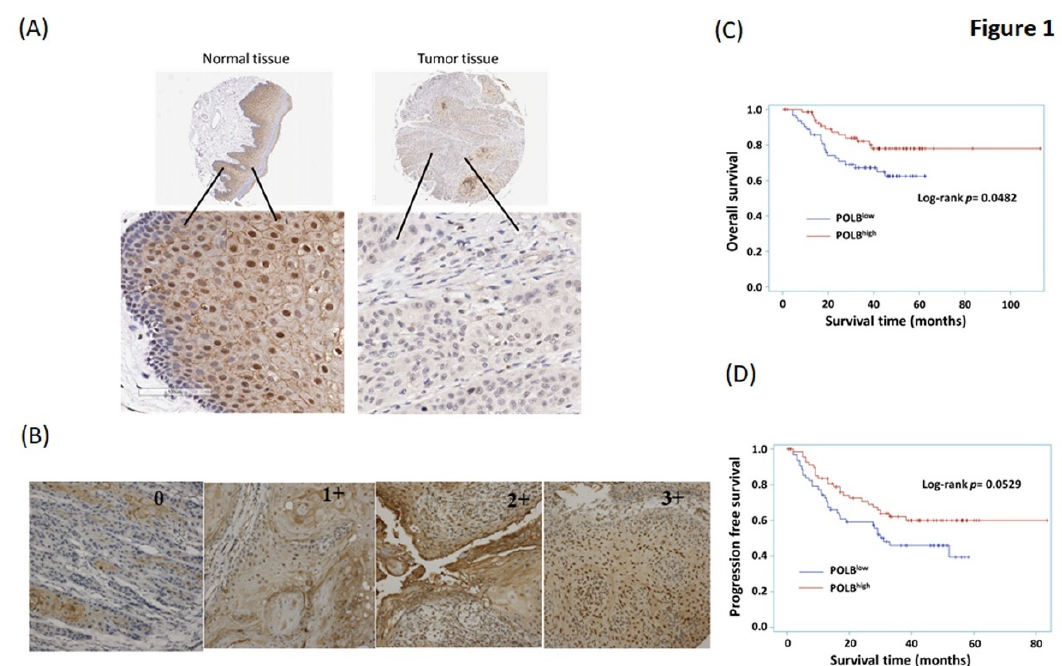
Figure 1. Representative immunohistochemistry staining results of POLB in tumor cells of OSCC patients, evaluation of POLB expression as a favorable prognostic marker in OSCC patients, and comparison of POLB protein expression between normal and OSCC cells in tissue array. ( A ) IHC representative images of POLB in OSCC cancer tissue sections are shown. ( B ) Immunoreactivity of POLB was classified as negative or positive (1+, 2+ and 3+) according to staining observed in the cell nucleus; magnification, 200 × . ( C ) The Kaplan–Meier curves of progression-free survival for our OSCC patients. ( D ) The Kaplan–Meier curves of overall survival for our OSCC